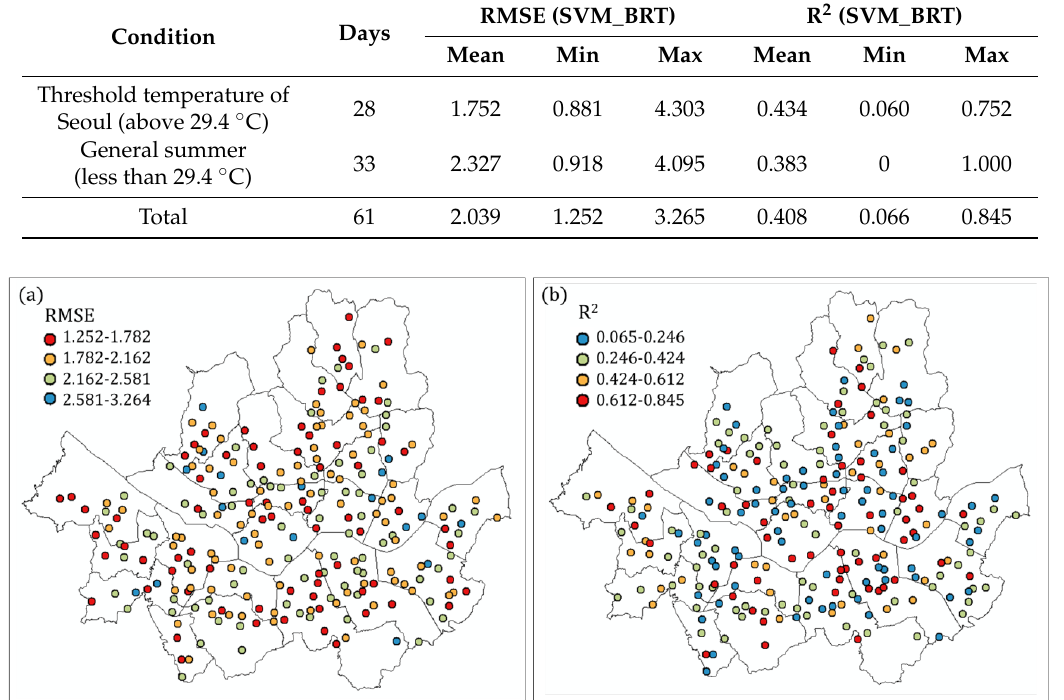
Figure 13. Spatial distribution of evaluation results according to DT max data for all days. The evaluation indices using high-density observational data are RMSE ( a ) and R 2 ( b ).